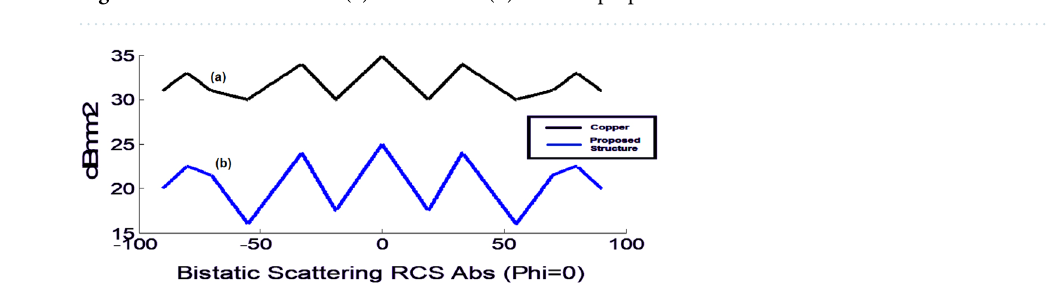
Figure 11. Curved structure ( a ) without and ( b ) with the proposed absorber.